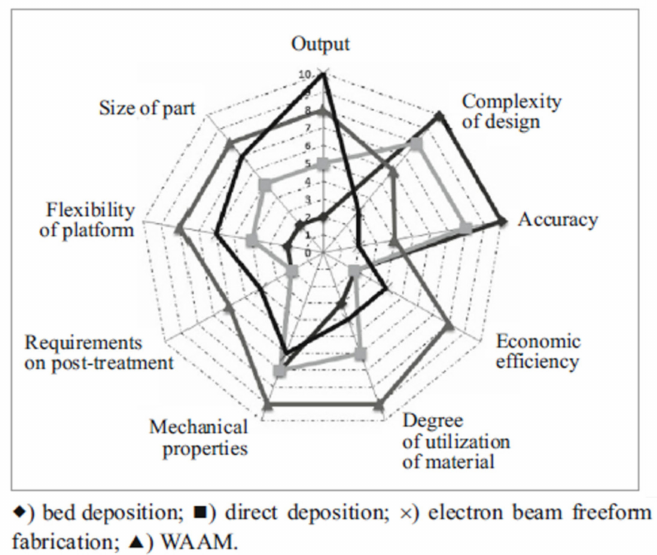
Figure 6. Advantages of WAAM and other additive manufacturing processes